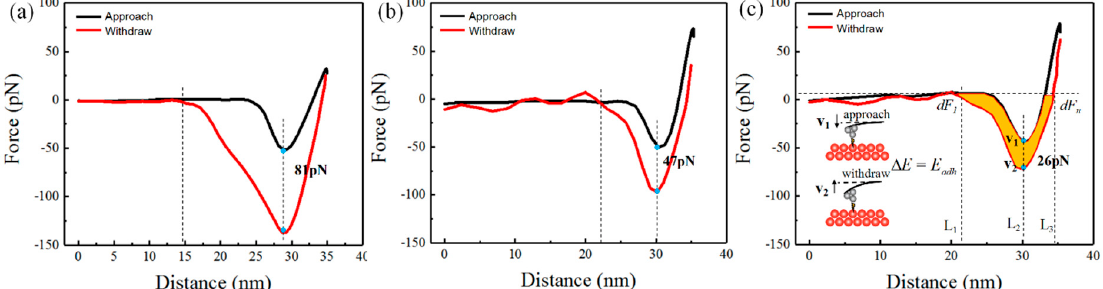
Figure 7. Force curve at three paraffin coatings produced by open-type evaporation, closed-type rapid cooling evaporation, and closed-type precise temperature-controlled evaporation, respectively: ( a – c ) is measured at points a–c in Figure 4.